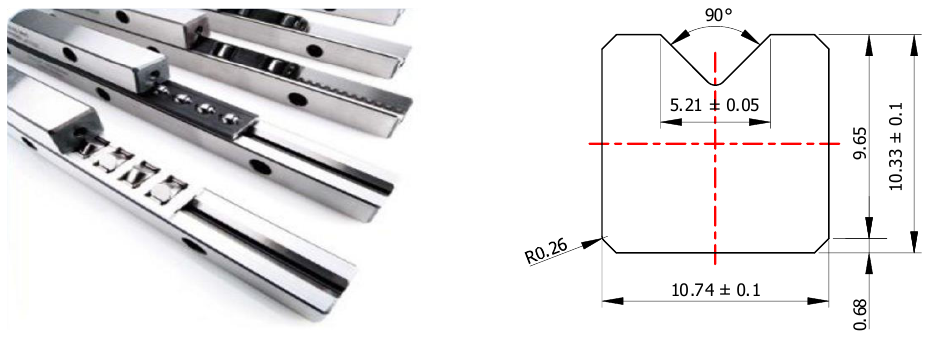
Figure 1. Photograph and dimensions of the cross-roller guide (unit: mm).